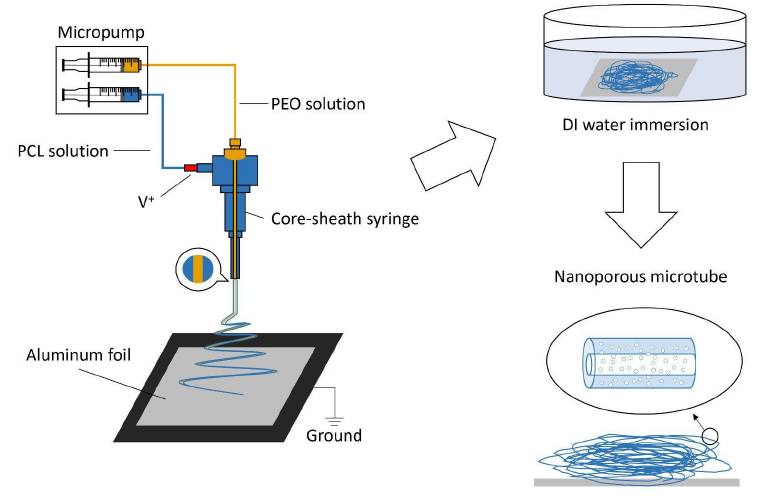
Figure 1. Schematic illustration of processing the electrospun.